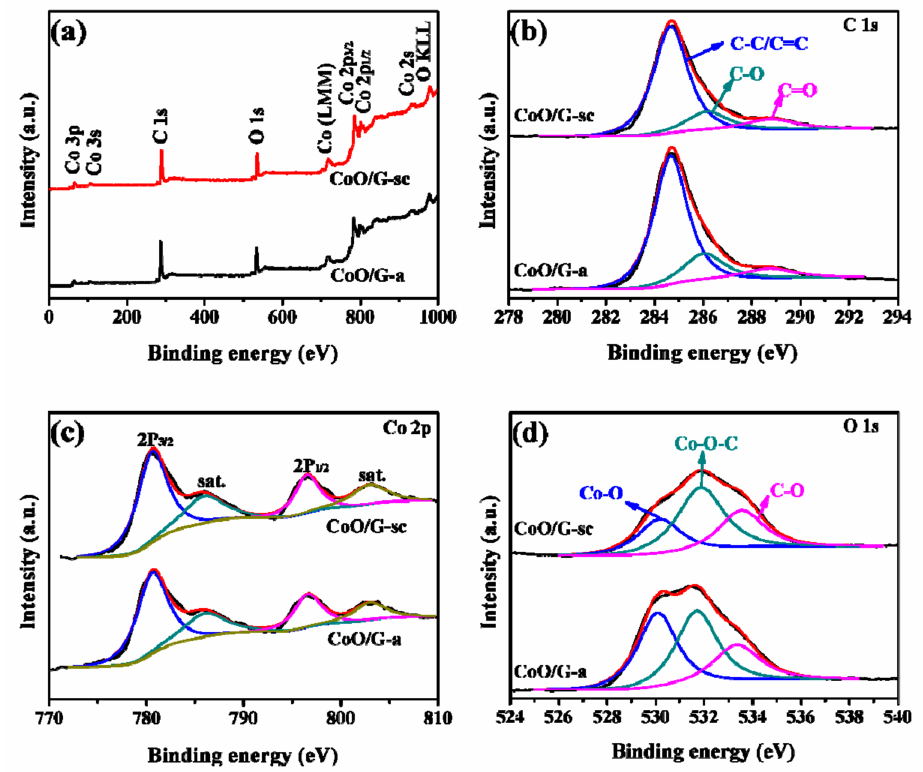
Figure 2. ( a ) X-ray photoelectron spectroscopy (XPS) spectra of CoO/G-sc and CoO/G-a; High-resolution ( b ) C 1s, ( c ) Co 2p and ( d ) O 1s XPS spectra of CoO/G-sc and